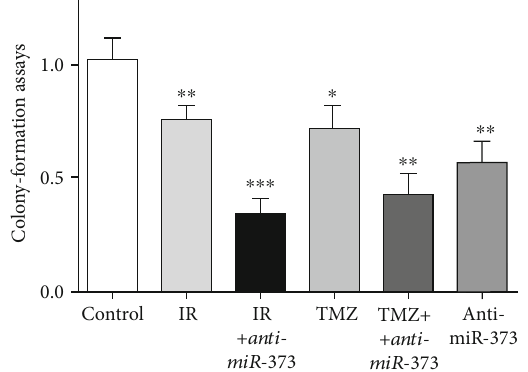
Figure 3: Inhibition of miR-373 reduced the U-251 cells ’ colony formation. Colony formation assays were performed to evaluate the e ff ects of anti-miR-373 on U-251 cells in vitro . Reducing the miR-373 level, TMZ or IR treatment could decrease the colony formation of U-251 cells obviously, and additional e ff ects were obtained in the combined groups, respectively (bars indicate the standard deviation of the mean; each experiment was performed in triplicate; ∗∗∗ p < 0 : 001 ; ∗∗ p < 0 : 01 ; ∗ p < 0 : 05 ).